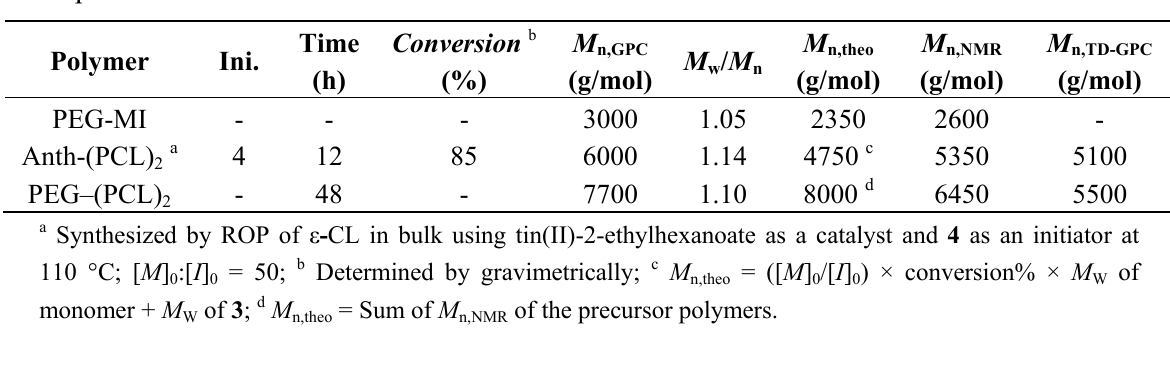
Table 2. The conditions and characterization data of the Y-shaped block copolymer and its